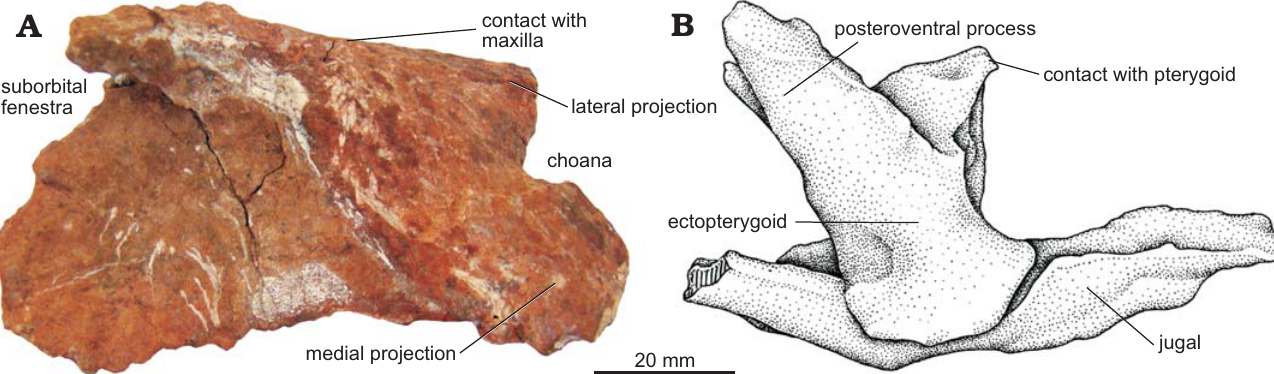
Fig. 15. The pseudosuchian archosaur Prestosuchus chiniquensis Huene, 1938 (UFRGS-PV-0629-T) from the Dinodontosaurus Assemblage Zone, Ladinian, Middle Triassic, Dona Francisca municipality, Rio Grande do Sul State, Brazil. A . Photograph of the left palatine in dorsal view. B . Explanatory drawing of the left ectopterygoid articulated with the jugal in ventral